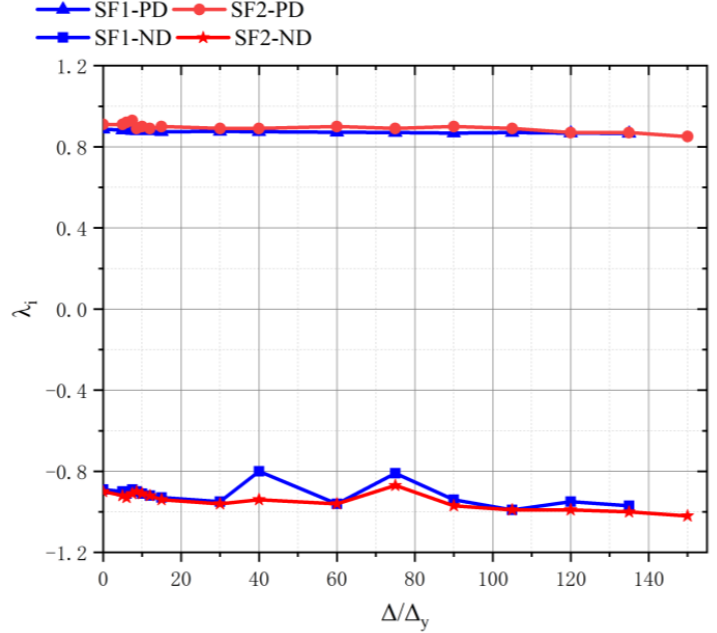
Figure 17. Strength degradation curves of SF-1 and SF-2.